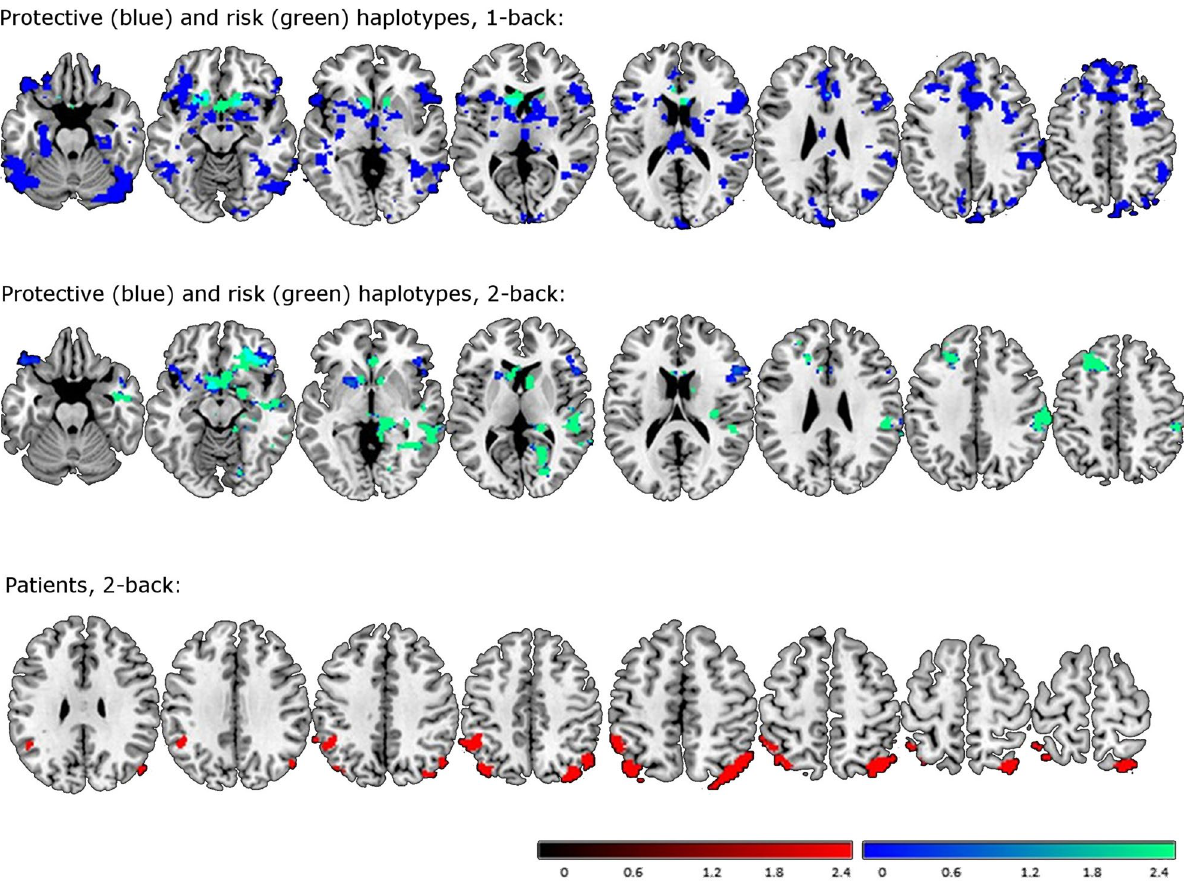
Figure 2. Brain hyper- and hypo-activation depending on ADGRL3 haplotypes and the attention-deficit/ hyperactivity disorder (ADHD) status during the N-back task. Top: Hypo-activation in individuals (patients or controls) with the protective haplotype (blue) and with the risk haplotype (green) during the performance of the 1-back task vs. baseline. The light-blue color shows overlap regions in both groups. Middle: Hypo-activation in individuals (patients or controls) with the protective haplotype (blue) and with the risk haplotype (green) during the performance of the 2-back task vs. baseline. The light-blue color shows overlap regions in both groups. Bottom: Hyper-activation in patients with ADHD relative to healthy control during the 2-back vs. baseline task. Color bars indicate z-values from the group-level